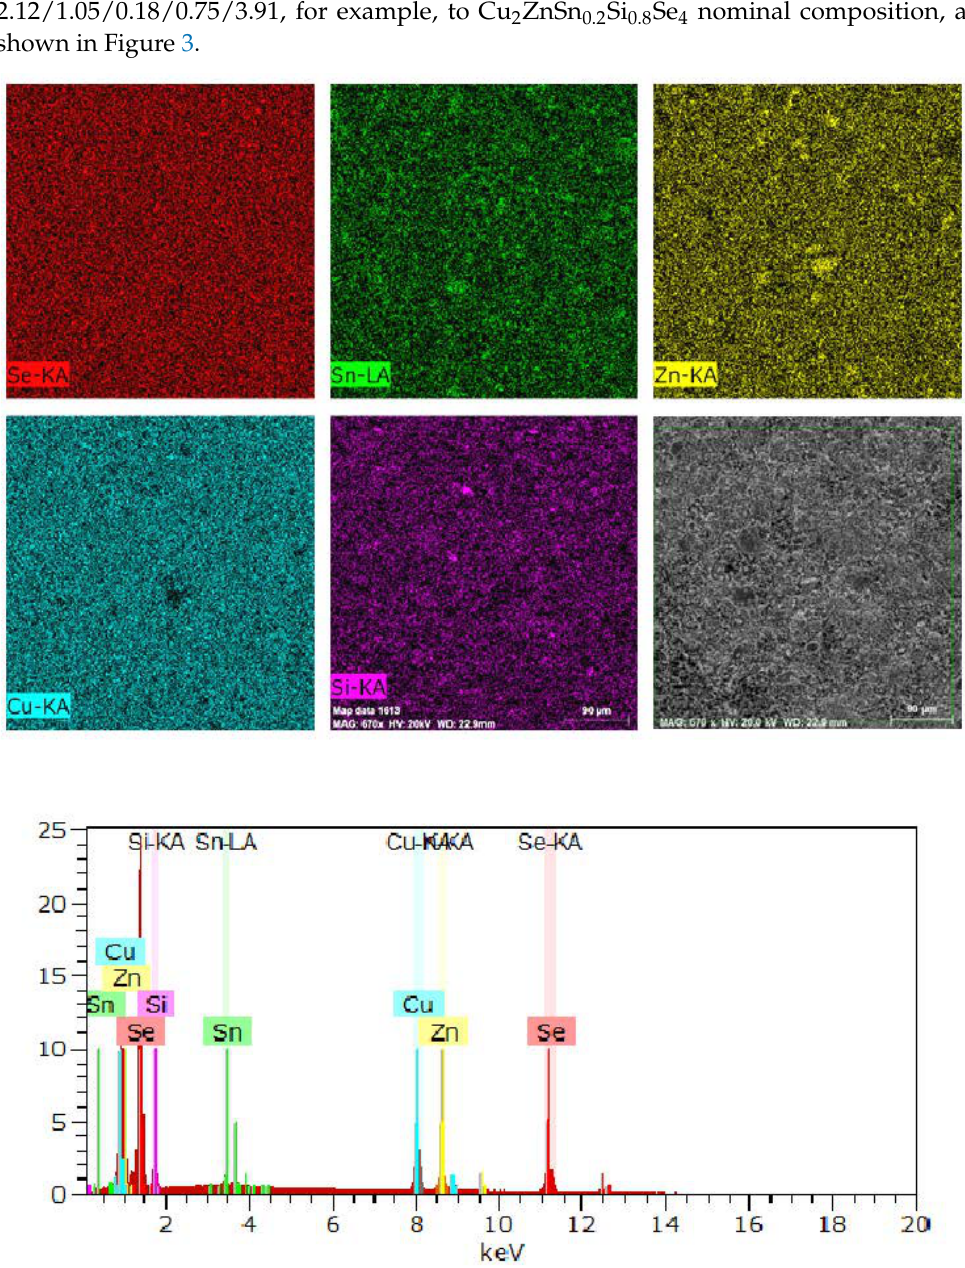
Figure 3. Scanning electron microscopy analysis: Representative energy-dispersive X-ray spec- troscopy mapping spectral analysis (powder sample) and backscattering electron image of Cu 2 ZnSn 0.2 Si 0.8 Se 4